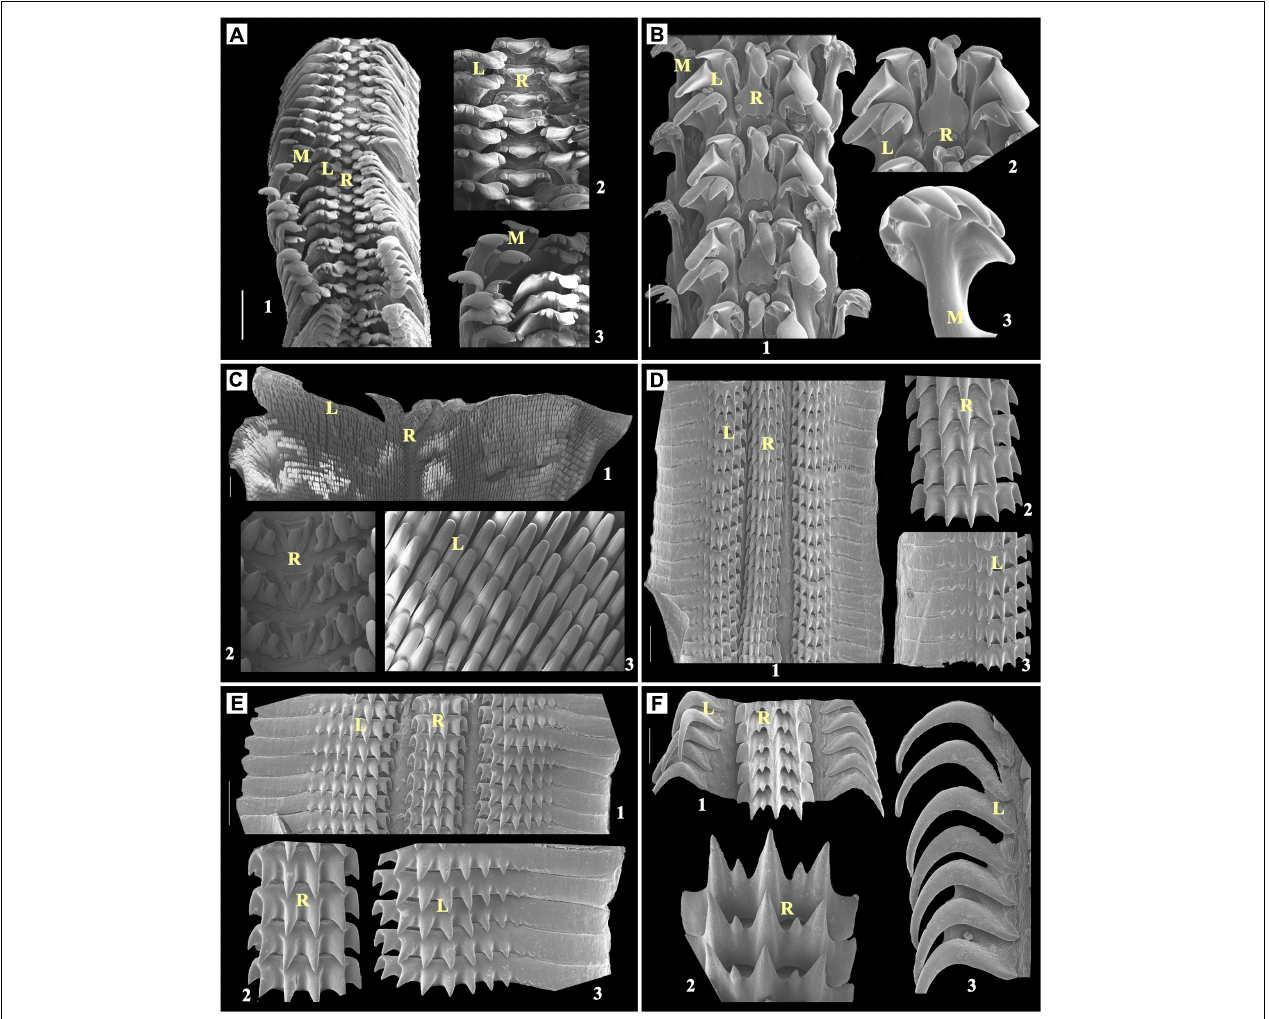
FIGURE 4 | (A) Clypeomorus bifasciata , Scale bar: 200 µ m; (B) Echinolittorina pascua , Scale bar: 50 µ m; (C) Peronia verruculata , Scale bar: 500 µ m; (D) Scabricola guttata , Scale bar: 50 µ m; (E) Strigatella scutulata , Scale bar: 100 µ m; (F) Murex sp., Scale bar: 50 µ m; 1: radula; 2 and 3: enlarged part of radula; R, rachidian teeth; L, lateral teeth; M, marginal